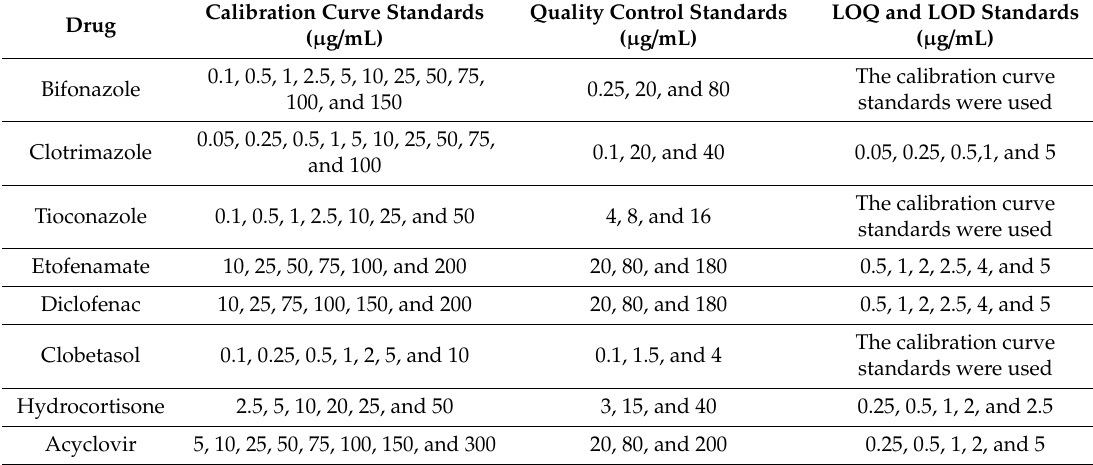
Table 3. Concentrations used for calibration curve, quality control, and limits of detection (LOD) and limits of quantification (LOQ)